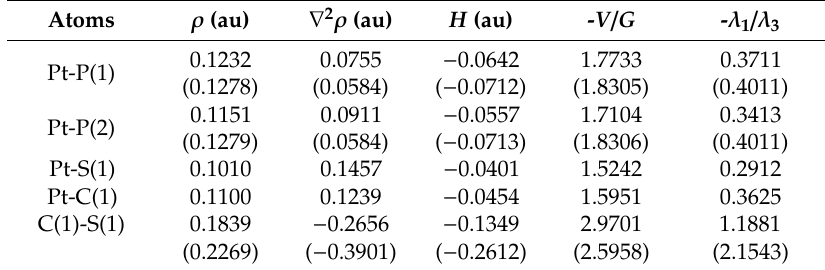
Table 3. Calculated QTAIM parameters of bond critical points for the bonds around the Pt center in complex 3c . For some of the bonds, their QTAIM parameters calculated for the isolated 1a and (dppf)Pt are presented in parentheses.